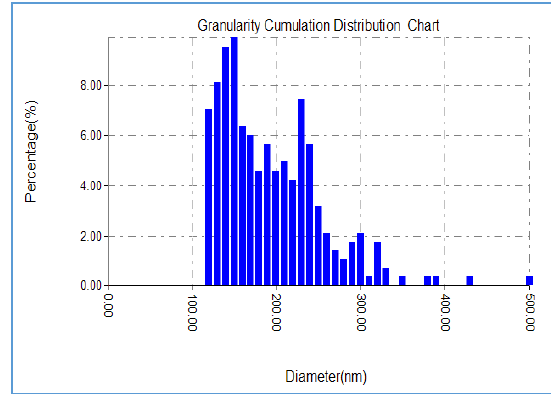
Figure 14. Granularity cumulation distribu- tion of darifenacin hydrobromide loaded NLCs ( F16)